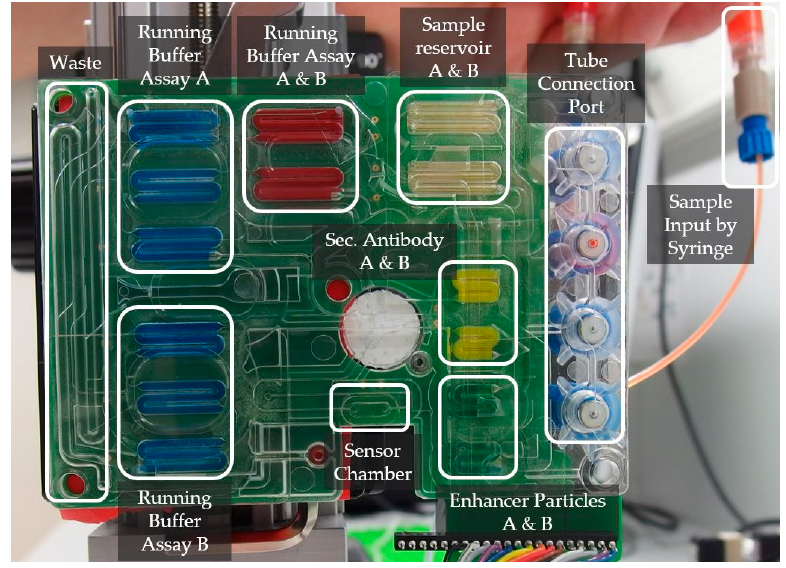
Figure 3. The picture of the newly-designed cartridge shows the reservoirs filled with colored water except the sample reservoirs. The sample is filled into the corresponding reservoirs using an external manipulator through tubing’s connected to a port with high performance liquid chromatography (HPLC)-fitting compatible threadings. The PIC is not shown here.